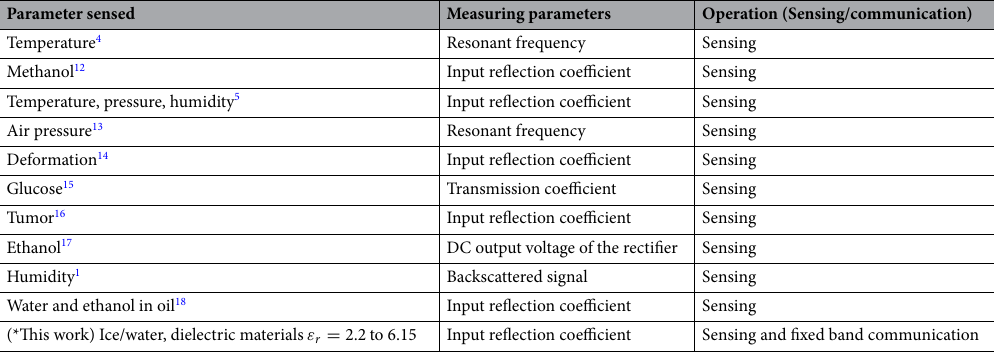
Parameter sensed Measuring